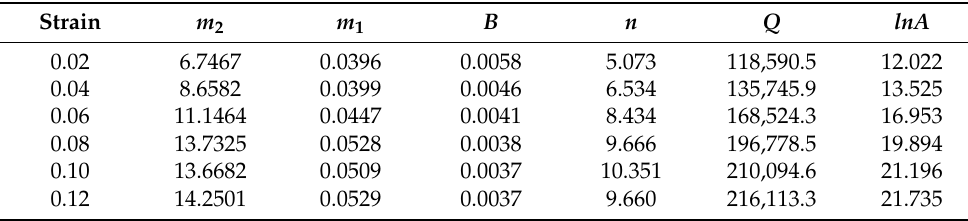
Table 6. Fitting results of each parameter of the constitutive equation. Strain